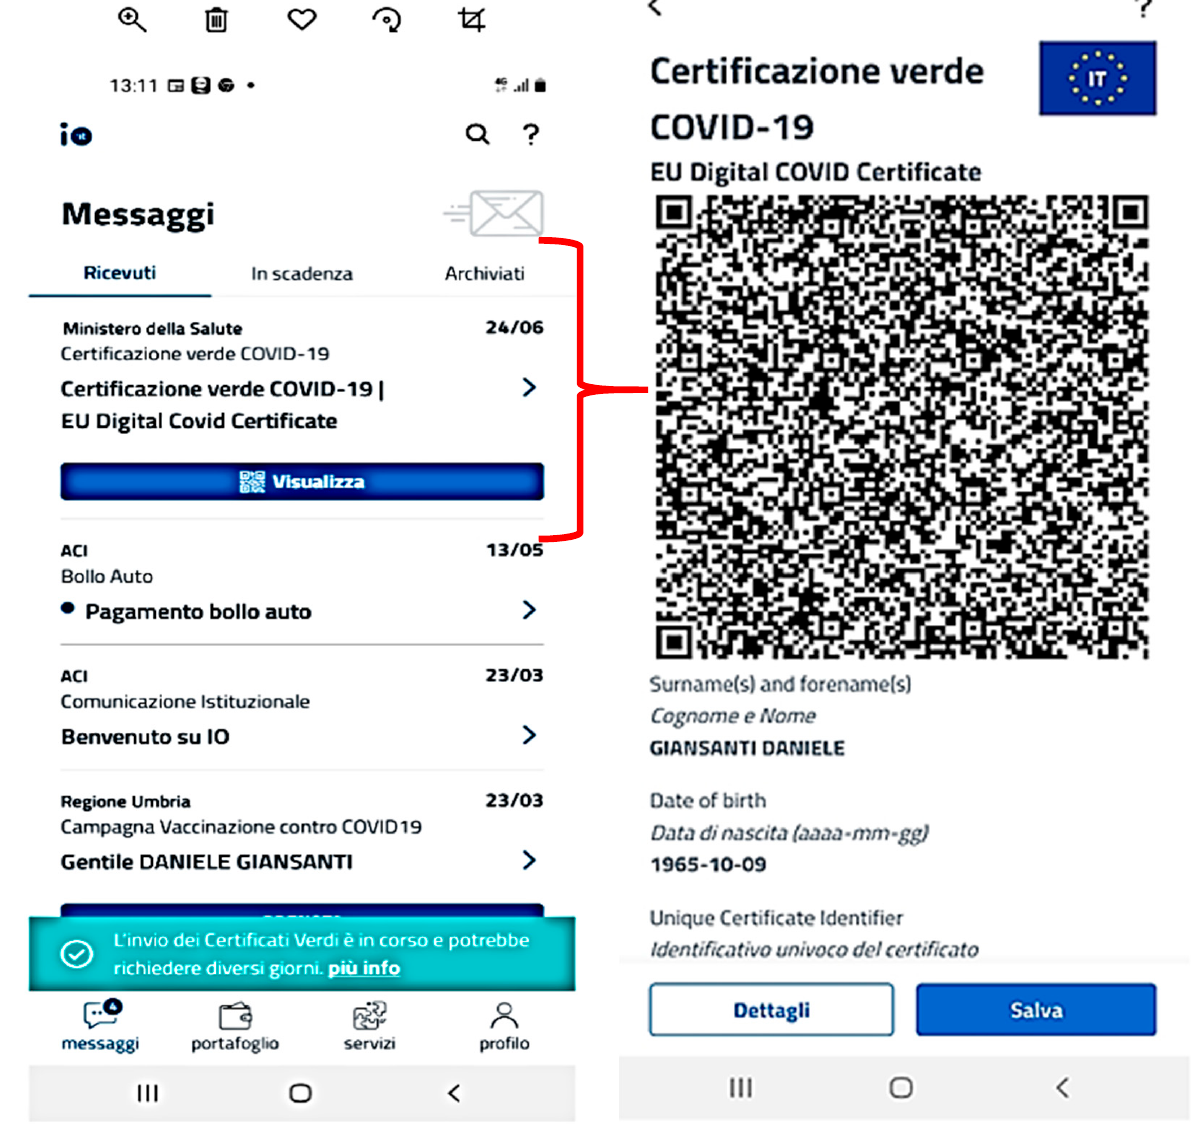
Figure 4. The message box related to the EU COVID-19 vaccine certificate ( left ) and the final EU certificate, with the English translation ( right ) after the download.